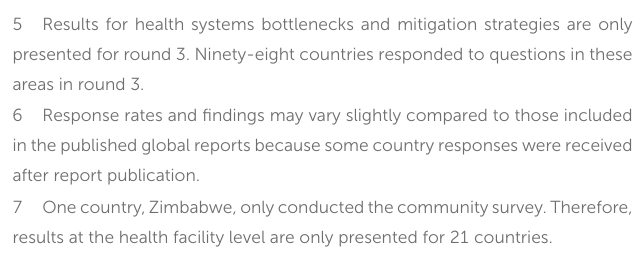
all major condition- or programme-specific tracer health areas (Figure 1B)